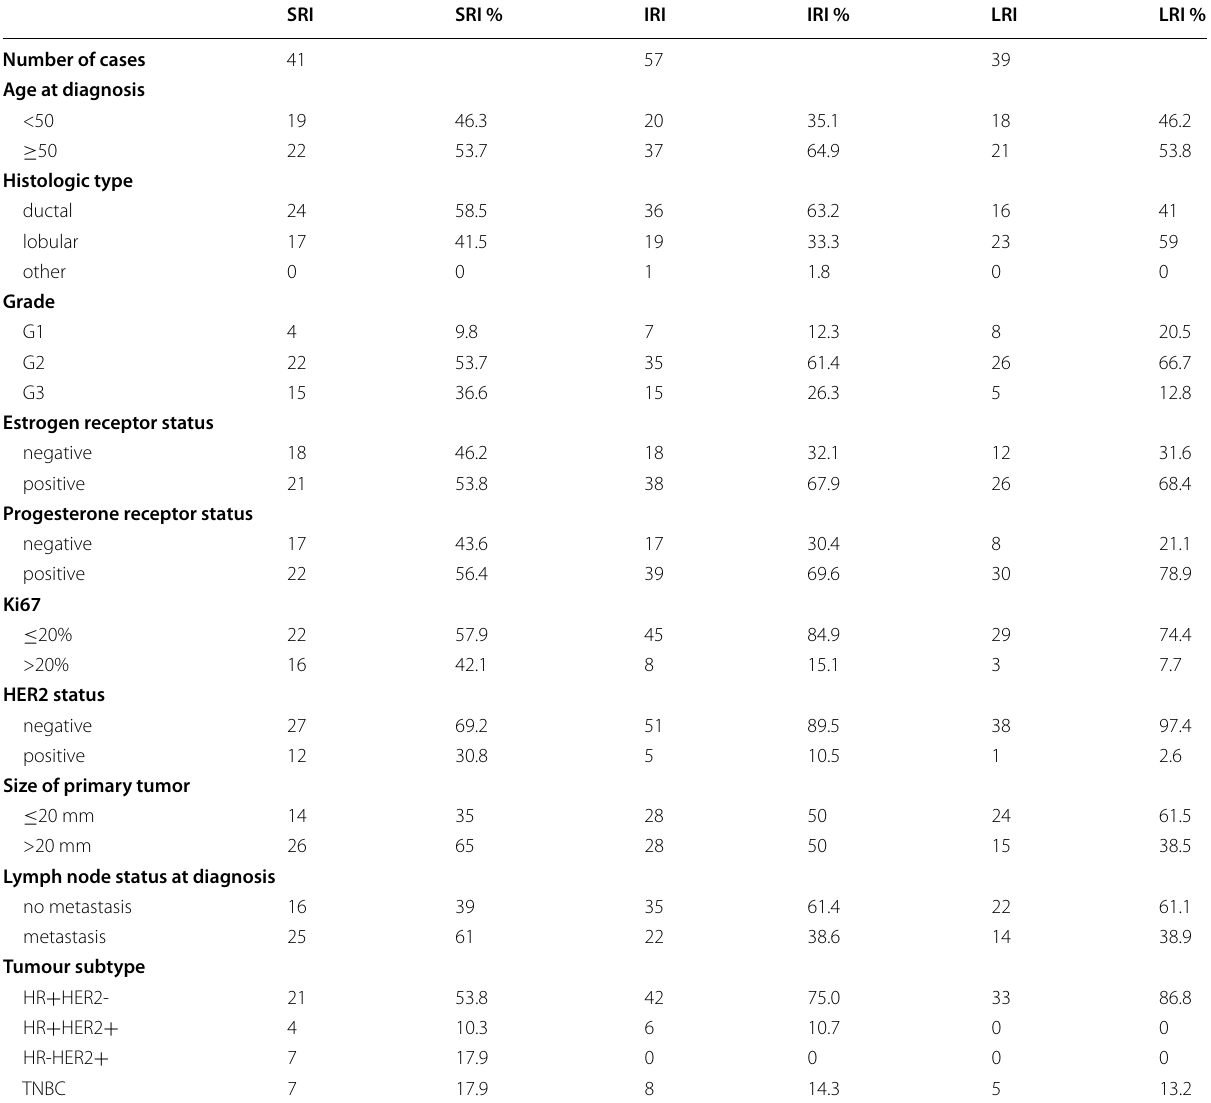
Table 1 Clinocopathologic information of the